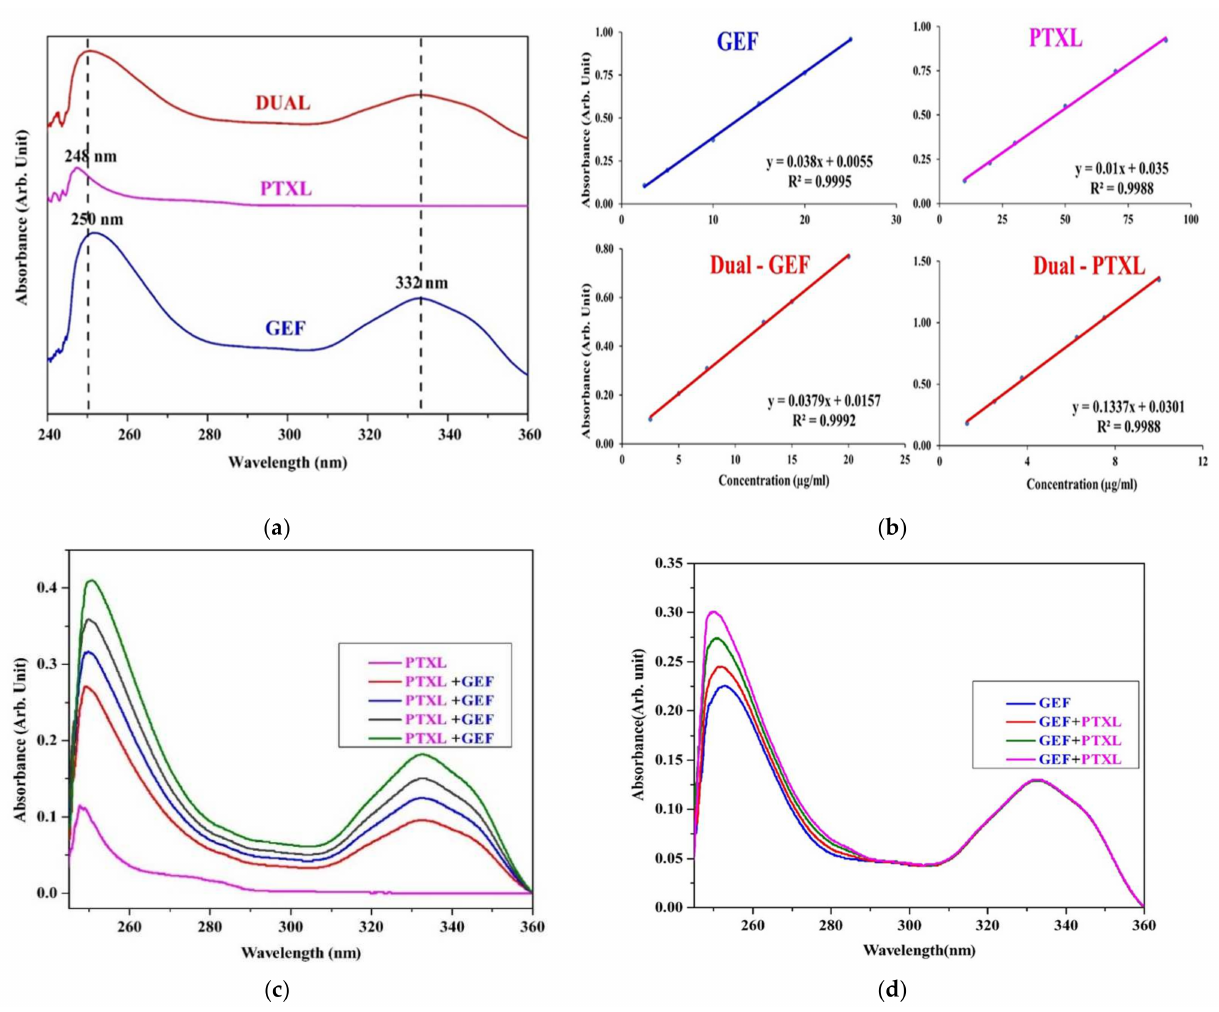
Figure A1. UV-Vis spectrophotometric studies ( a ) UV-vis absorption spectra of GEF, PTXL and DUAL (GEF + PTXL) with its significant peaks ( λ max) in an equal admixture of DMSO and 0.05% ( v / v ) Tween 80; ( b ) Calibration curve of GEF, PTXL, dual-GEF and dual-PTXL in an equal admixture of DMSO and 0.05% ( v / v ) Tween 80, with concentration ( µ g/mL) in the x -axis and absorbance (Arb. unit) in the y -axis. ( c ) Spectra generated with GEF at a constant concentration and increasing concentrations of PTXL, indicating rise in both the peaks at 248 nm and 332 nm; ( d ) Spectra generated with PTXL at a constant concentration and increasing concentrations of GEF, indicating rise in the peak assigned to PTXL at 248